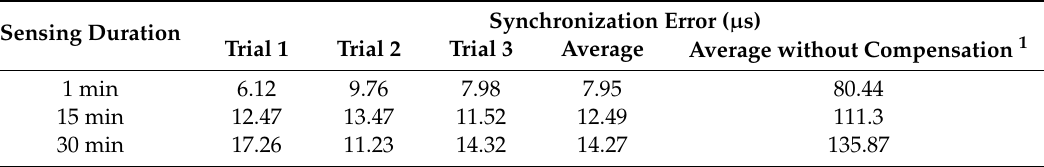
Table 4. Time-synchronization results from LBCB tests.